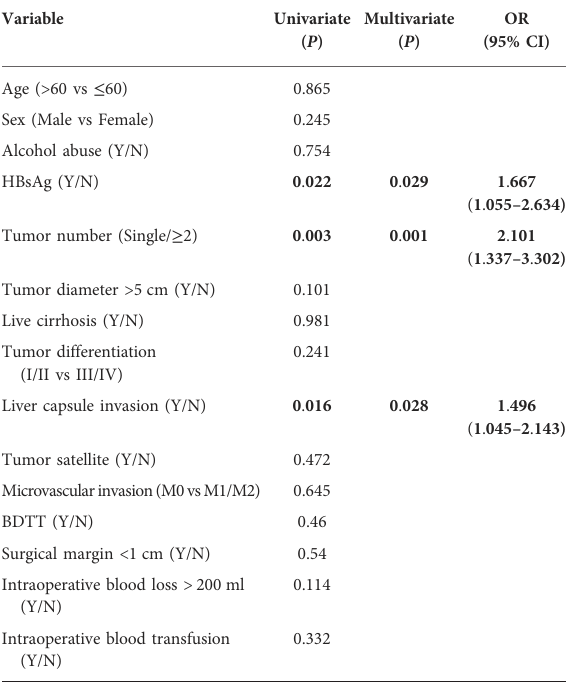
TABLE 2 Univariate and multivariate analysis of prognostic factors that related with tumor